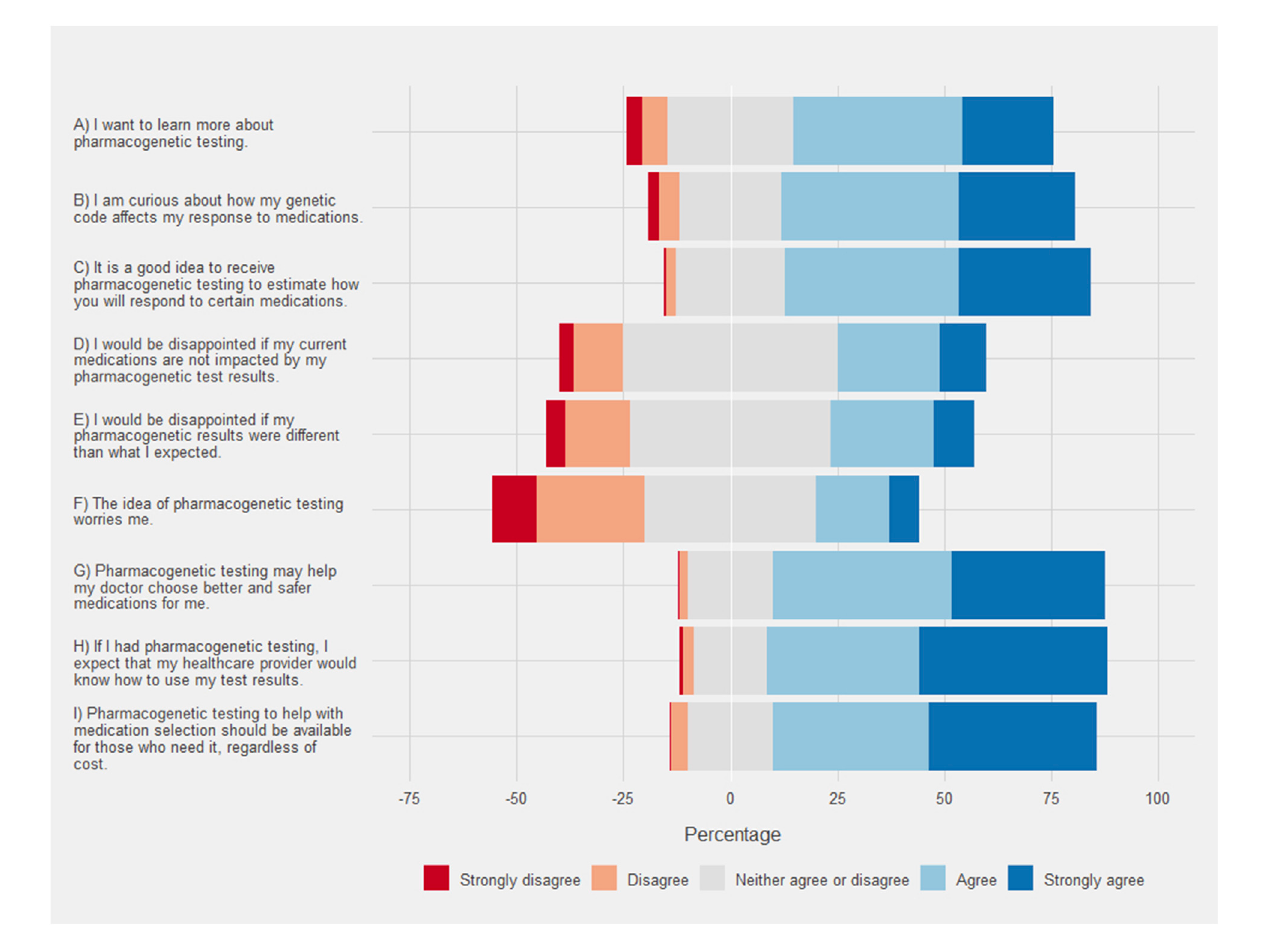
FIGURE 3 Respondent attitude and perceptions of pharmacogenetic testing. Each bar corresponds to the percentage of each group on a Likert scale where the neutral response is centered on zero. Agreement is show in positive percentages (light blue and blue) and disagreement is shown as negative percentages (light red and